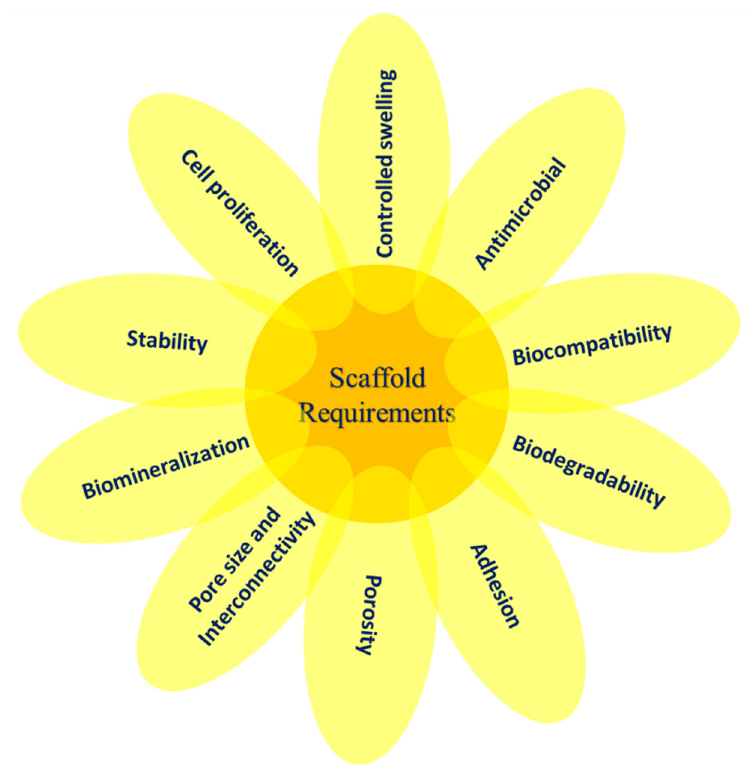
Figure 1. The essential variables involved in scaffold design for TE.